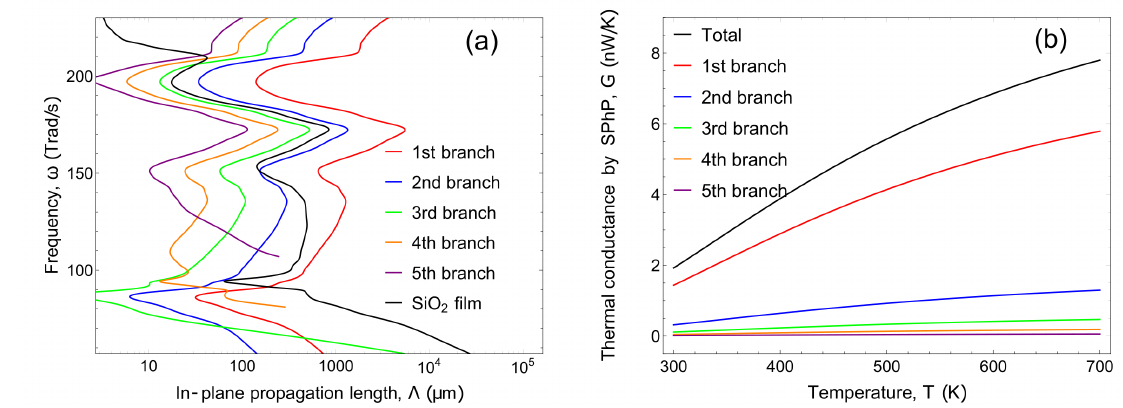
Figure 4. ( a ) The in-plane propagation length and ( b ) thermal conductance of SPhPs. The structure consists of the layered system, SiO 2 (1 µ m)/Si (10 µ m)/SiO 2 (1 µ